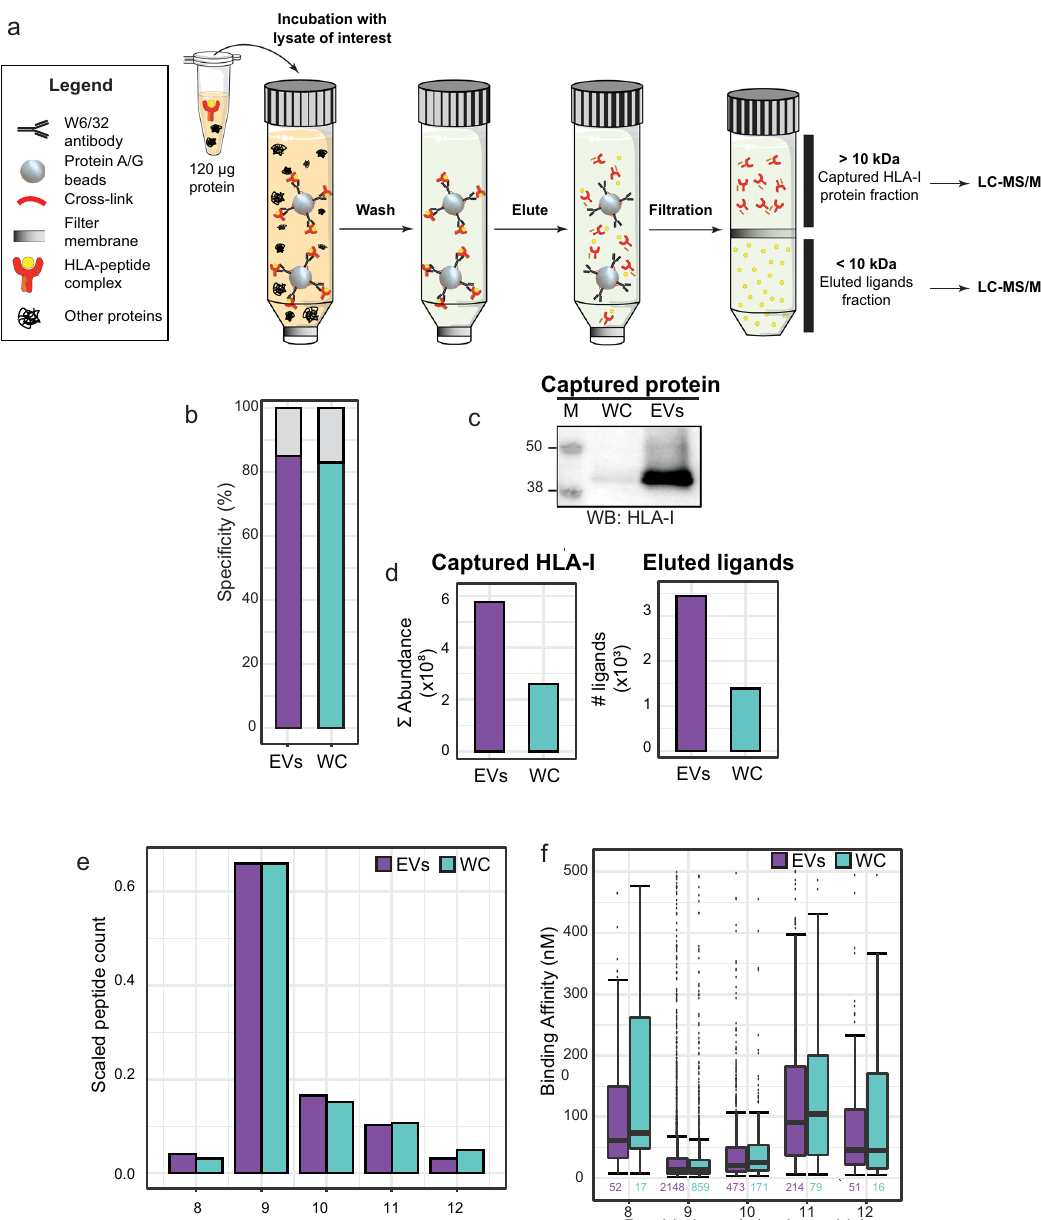
Fig. 2 Global characterization of the EV HLA-I peptide ligandome. a Preparative steps in the down-scaled HLA-I complex retrieval work fl ow. An input load of 120 μ g was used for immunoaf fi nity puri fi cation of HLA-I complexes from both WCL and EVL. The fl owthrough from 10 kDa fi ltration contains HLA peptide ligands that were subjected to LC-MS/MS analysis. The retentate contains HLA-I and HLA-I interacting proteins, which were digested, for the analysis of HLA-I abundance and interactome. b HLA-I peptide ligand speci fi city. From the 10 kDa fl owthrough fraction, more than 80% of peptides detected were predicted to bind to the JY HLA type (HLA-A*02:01; HLA-B*07:02; HLA-C*07:02). c Western blot (WB) detection of HLA-I. HLA-I was detected in the eluate of WCL HLA-I IP, and more strongly in the eluate of EVL HLA-I IP. Full image provided in Supplementary Fig. 9. d Mass spectrometry analysis of immuno-puri fi ed HLA-I proteins and HLA-I peptide ligands. From EVs, more HLA-I proteins (cumulative MS intensities of HLA-A, HLA-B and HLA-C) and HLA-I peptide ligand species were detected. e Peptide length distribution. HLA-I peptide ligands from both whole-cells (WC) and EVs distributed similarly, and expectedly, between 8 to 12 amino acids. f Predicted binding af fi nity. Marginal differences in predicted binding af fi nity were observed in HLA-I peptides retrieved from WC and EVs. Box plots represent n peptides (where n has been annotated under each box). The 25%, 50% (median), and 75% quantiles are represented in each box, and the whiskers represent the ±1.5*IQR from the closest quantile. Bar plots represent the total pool of eluted ligands detected in three technical replicates from either WC (green) or EVs